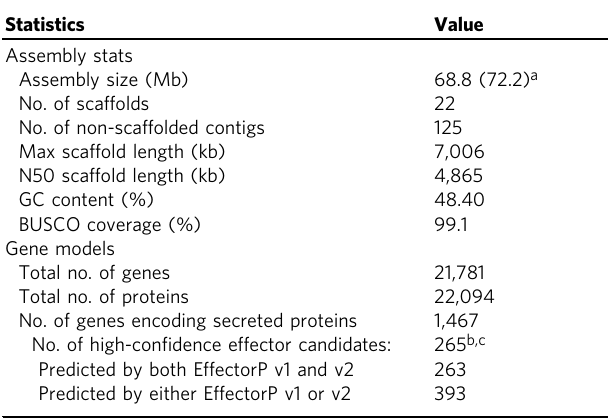
Table 1 Focn Cong:1-1 genome